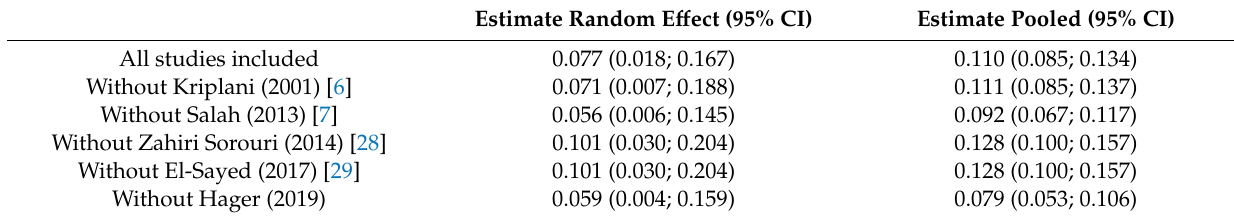
Table 2. Estimates and 95% confidence intervals obtained in a leave-one-out sensitivity analysis. The calculations are performed as in the main analysis. However, in each round of the sensitivity analysis one study is not